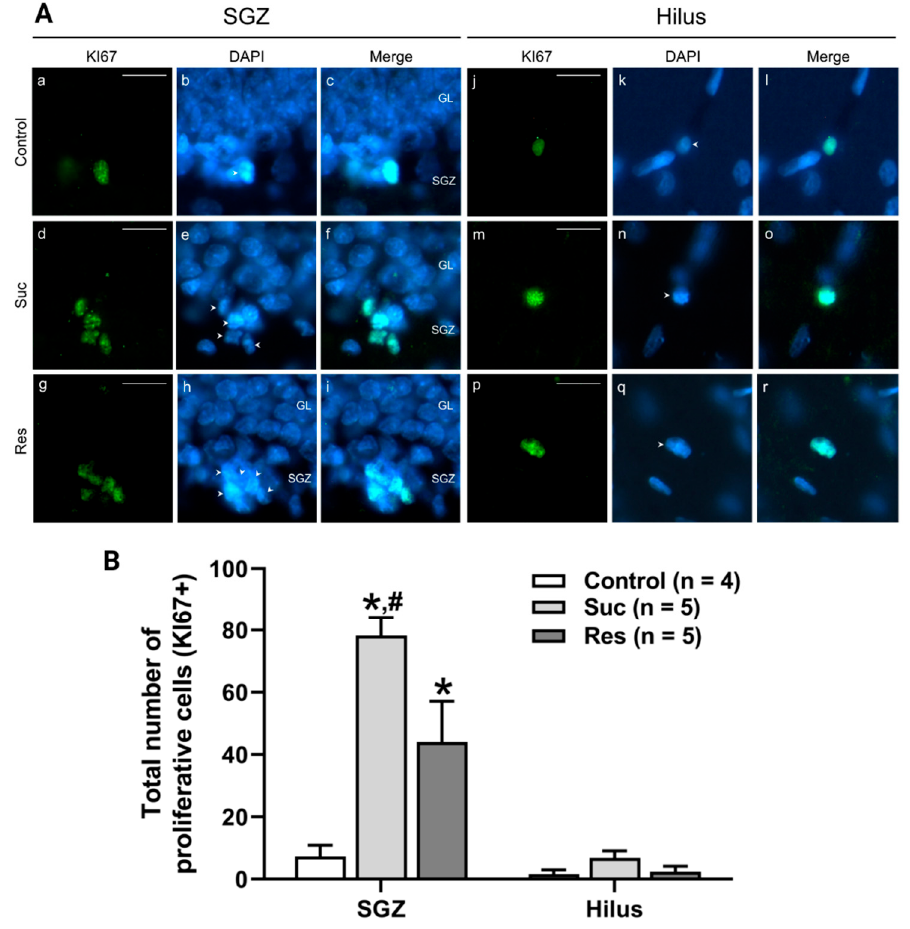
Figure 4. Sucrose consumption increases the number of proliferative cells (KI67+) in the subgranular zone of the ventral dentate gyrus. ( A ) Left: representative photomicrographs showing proliferative cells (KI67+, green), cell nuclei (DAPI, blue) and their merge in the subgranular zone (SGZ) of the ventral dentate gyrus in the control (a–c), Suc (d–f) and Res (g–i) groups. Right: representative photomicrographs of proliferative cells in the hilus of the ventral dentate gyrus in the control (j–l), Suc (m–o) and Res (p–r) groups. Arrowheads show the cell nuclei (DAPI+) that colocalized with KI67 marker. Note the abundance of proliferative cells in the SGZ of the ventral dentate gyrus in the Suc and Res groups. ( B ) Cell counting of proliferative cells located in the SGZ (left) or the hilus (right) of the ventral dentate gyrus. A higher number of proliferative cells were founded in the Suc and Res groups in comparison with the control group. Moreover, the number of proliferative cells was higher in the Suc group than in the Res group. No significant difference was found between groups when the hilus was analyzed. *: p < 0.05 vs control; #: p < 0.05 vs. Res. One-Way ANOVA followed by Tukey test. GL: granule cell layer. Scale bar: 20 µm.